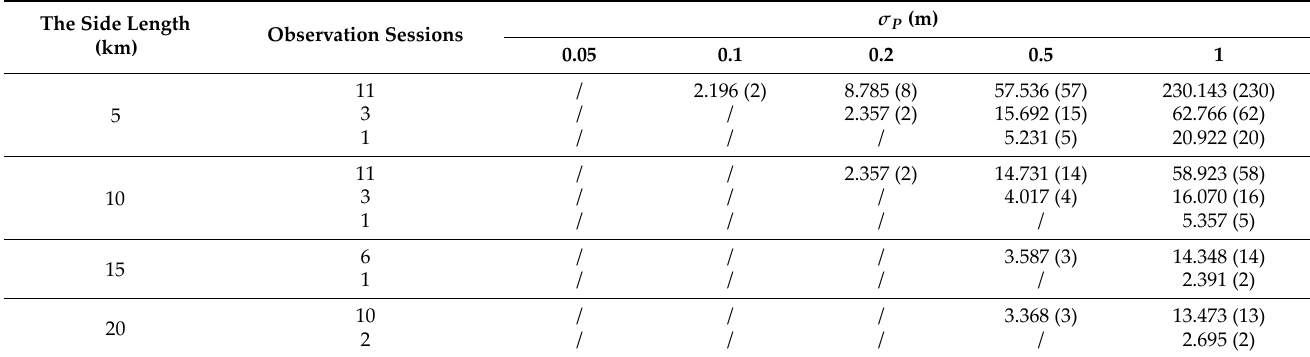
Table 7. The position of the weakest point under different side lengths and observation sessions in the square unit network.